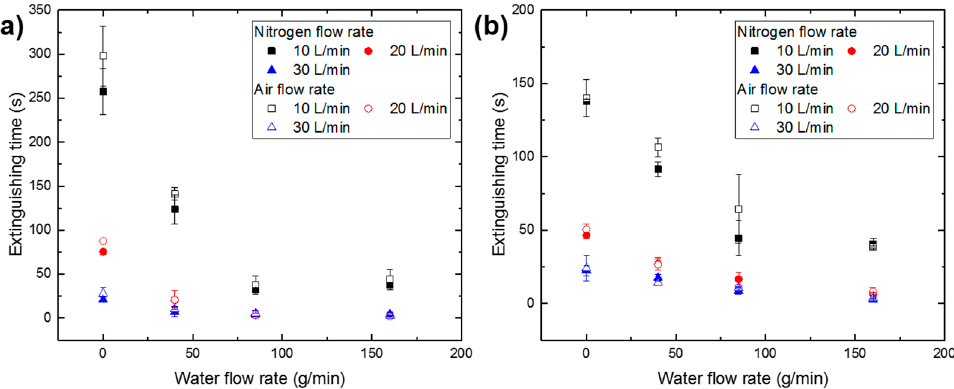
Figure 10. Extinguishing time for nitrogen and air (note that the scales of y -axis in both figures are different): ( a ) HRR = 1.17 kW and ( b ) HRR = 5.23 kW.